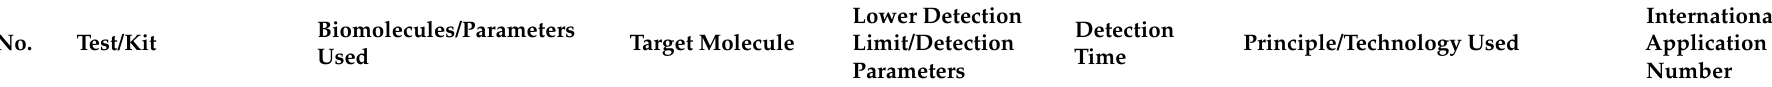
Table 5. Futuristic Diagnostic tools and new research in the field of diagnostics of COVID-19.